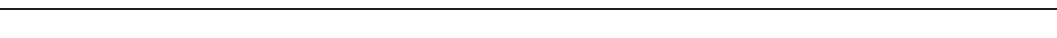
Fig. 1 Single-cell analysis reveals functional heterogeneity within individually stimulated pDCs. a Schematic overview of the droplet micro fl uidic assay. The pDCs were coated with cytokine capture reagents, encapsulated in picoliter droplets, and stimulated with TLR ligands. After incubation, cells were stained for viability, cytokine, and surface marker expression, and analyzed by fl ow cytometry. b Schematic overview of the employed micro fl uidic chip with microscopic image of the fl ow-focusing nozzle for the encapsulation of cells in droplets. c Microscopic image of emulsion after droplet production. b , c Red arrows indicate cells. Scale bars equal 100 µ m. d The pDCs were encapsulated at a concentration of 1,300,000 cells/mL in 92 pL droplets. The distribution of cells in droplets was measured by manual analysis of microscopic images showing the emulsion directly after production. Shown is the fraction of droplets plotted against the number of cells per droplet; n = 85, black line indicates median, red line indicates predicted values. e Shown is the fraction of cell-containing droplets with exactly one cell; n = 85. Lines indicate mean, hinges mark interquartile ranges, and whiskers reach to the highest/lowest value that is within 1.5 × interquartile range. f – k The pDCs were treated as described above and stimulated with 5 μ g/mL or 50 µ g/mL CpG-C. f Viable pDCs were detected by forward scatter (FSC) and side scatter (SSC) analysis and subsequent gating on CD14 − CD19 − and viability dye − cells. g IFN α - and TNF α - secreting cells were detected within that population. h Shown is the fraction of cytokine-secreting cells plotted against incubation time; n (5 µ g/mL) = 3, n (50 µ g/mL) = 6. i Surface marker-expressing pDCs were identi fi ed comparing the expression levels to fl uorescence-minus-one controls. j Shown is the fraction of surface marker-expressing cells plotted against the incubation time; n > = 4. k The co-expression of CCR7, CD40, CD86, and TNF α by single IFN α + and IFN α − pDCs was analyzed. Shown is the relative contribution of each functional response pattern to the total pDC population. h , j Dots indicate mean, error bars indicate